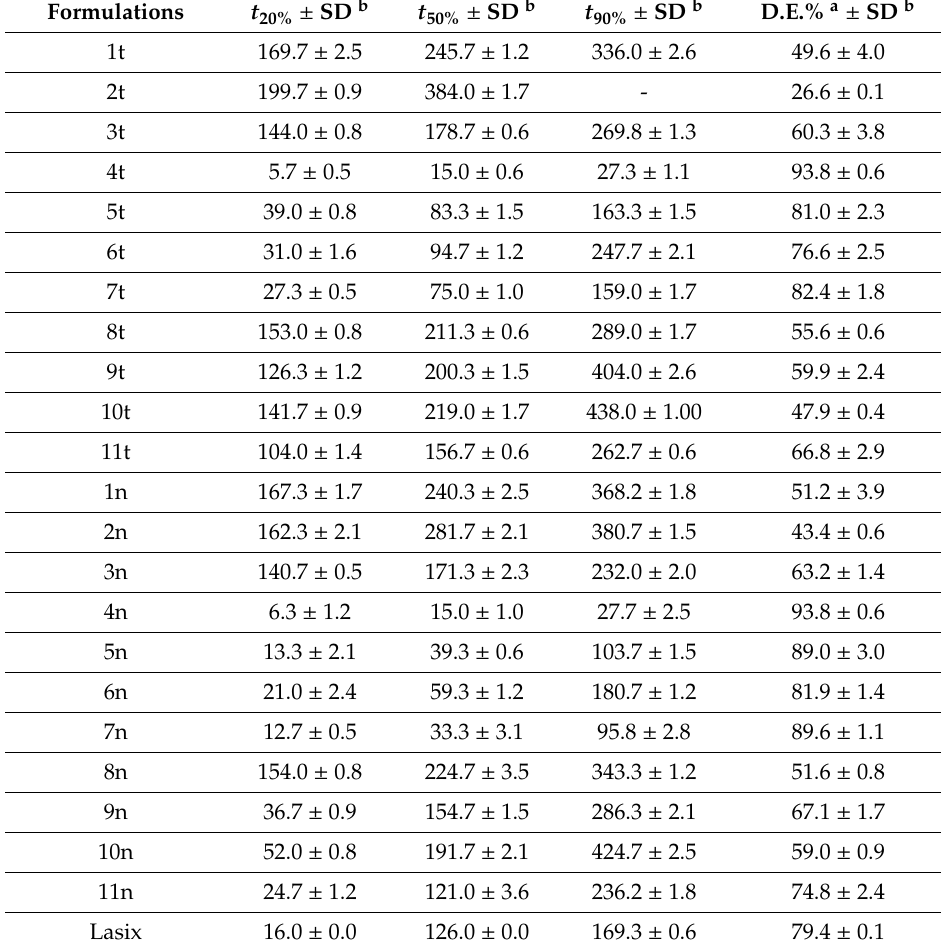
Table 4. Kinetic release properties of the developed formulations (1n–11n and 1t–11t) and Lasix ® .